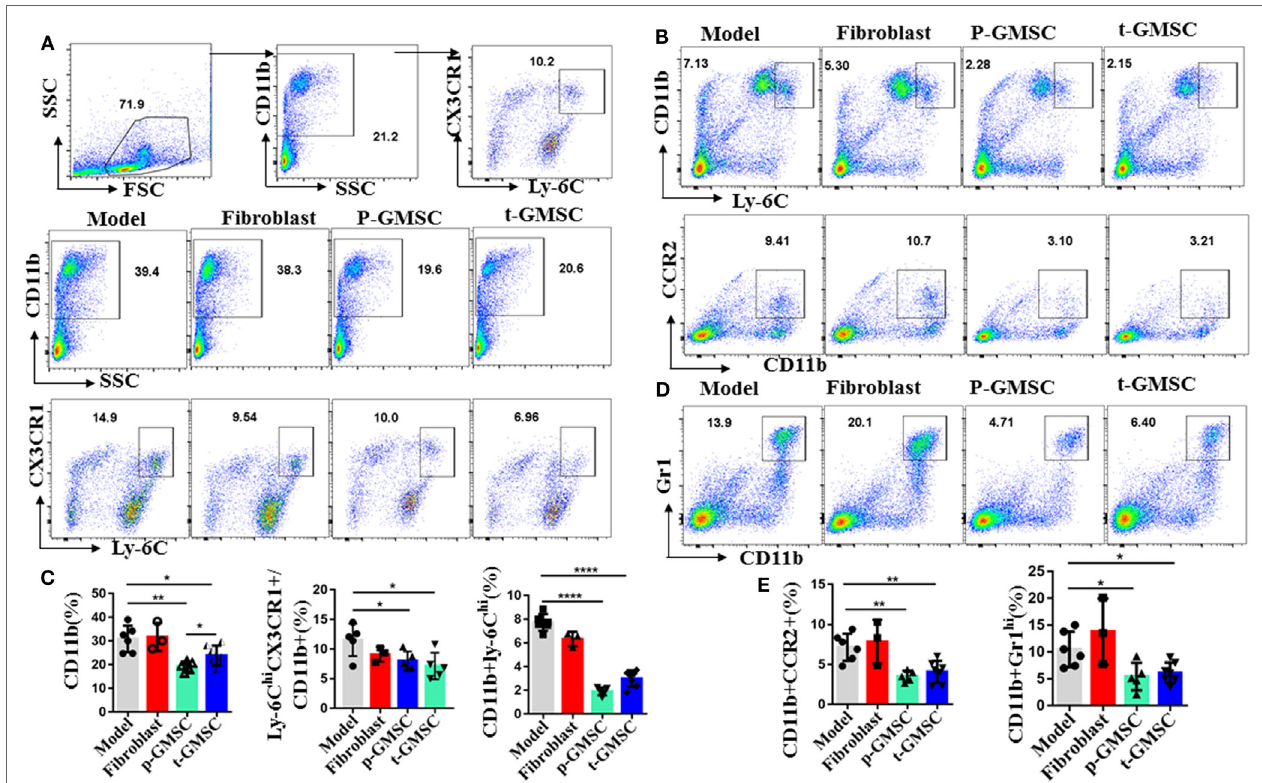
FigUre 2 | Human gingiva-derived mesenchymal stem cells (GMSC) decrease the expression of inflammatory Ly6C hi monocytes in ApoE − / − mice. The cells from spleen and draining lymph nodes of ApoE − / − mice were stained with anti-CD11b, -Ly-6C, Gr1, CCR2, and -CX3CR1 mAbs. Living cells were gated to determine percentages of CD11b + , the subsets of Ly-6C hi CX3CR + in CD11b + cells, CD11b + Ly6C hi , CD11b + CCR2 + , and CD11b + Gr1 hi . (a,B,D) Representative dot plots of individual mice from each group were depicted. (c,e) Bar graphs show the mean ± SD (model, n = 6; fibroblast, n = 3; p-GMSC, n = 5; t-GMSC, n = 7). * p < 0.05; ** p < 0.01; *** p < 0.001; **** p <